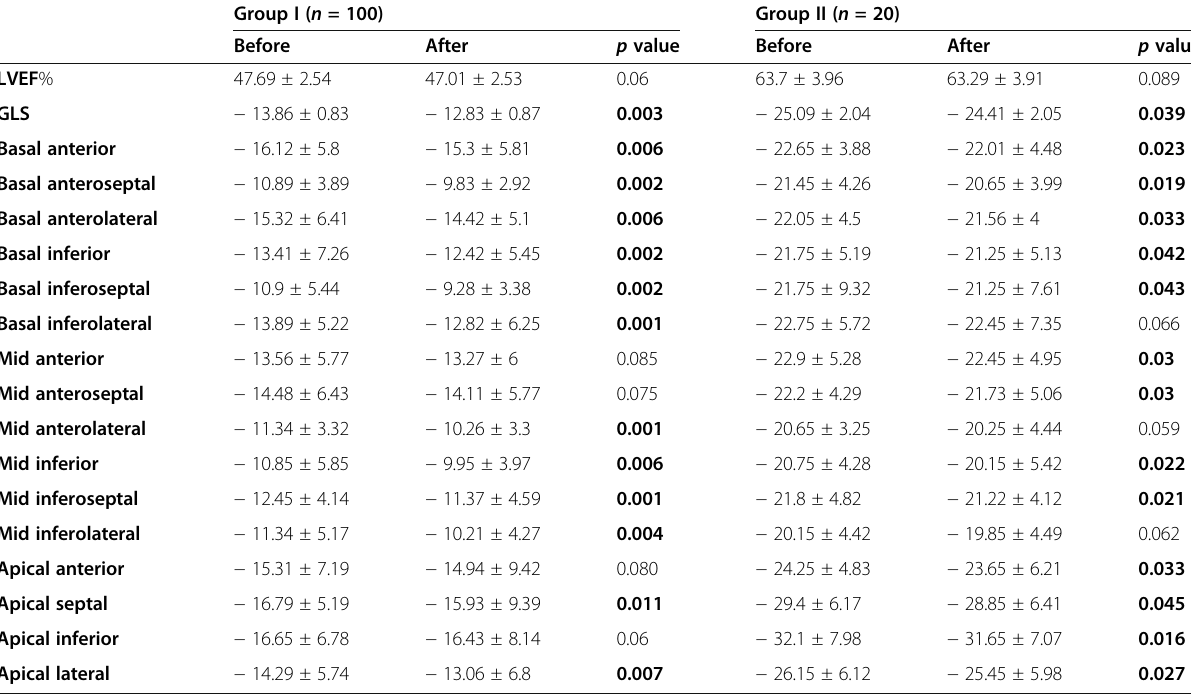
Table 2 The GLS, segmental strain, and estimated LVEF% in group I and group II before and after receiving antiviral treatment at each group Group I ( n = 100) Group II ( n = 20) Before After p value Before